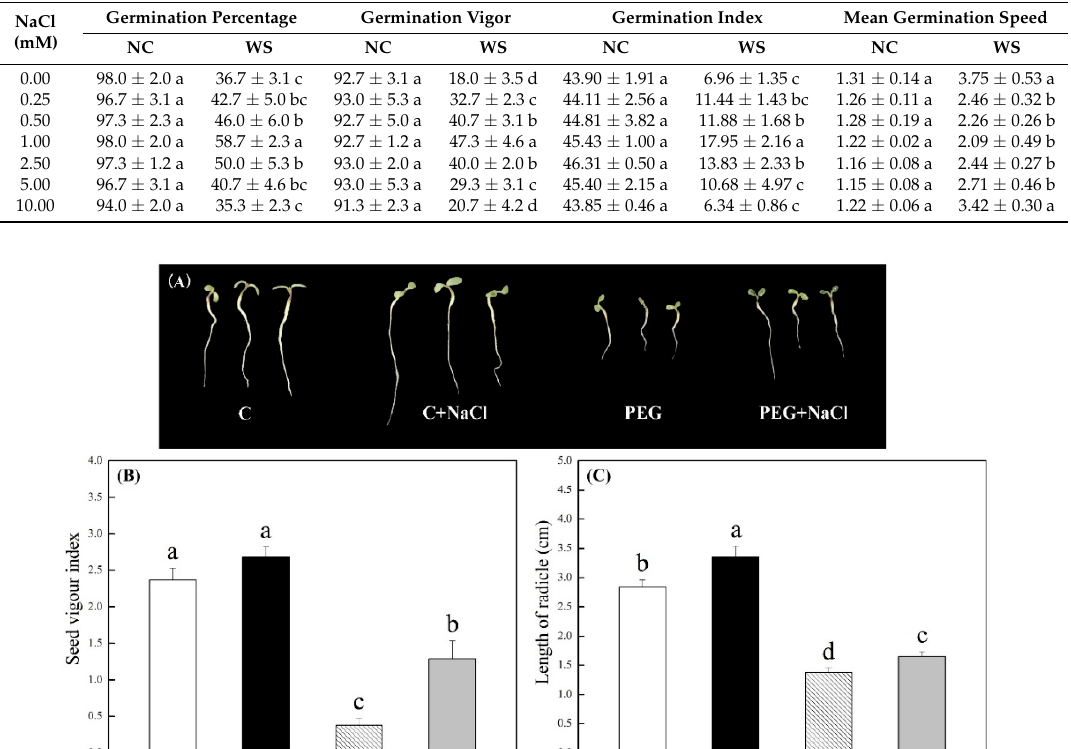
Table 1. Effects of seeds soaking with water or NaCl on the germination percentage (GP), germination vigor (GV), germination index (GI), and mean germination speed (MGS) during seven days of germination under normal conditions and water stress induced by 19% polyethylene glycol (PEG) 6000. Different letters in a vertical column indicate significant differences among different NaCl treatments under normal condition or water stress ( p ≤ 0.05). ±SE of mean ( n = 6). NC, normal condition; WS water stress.